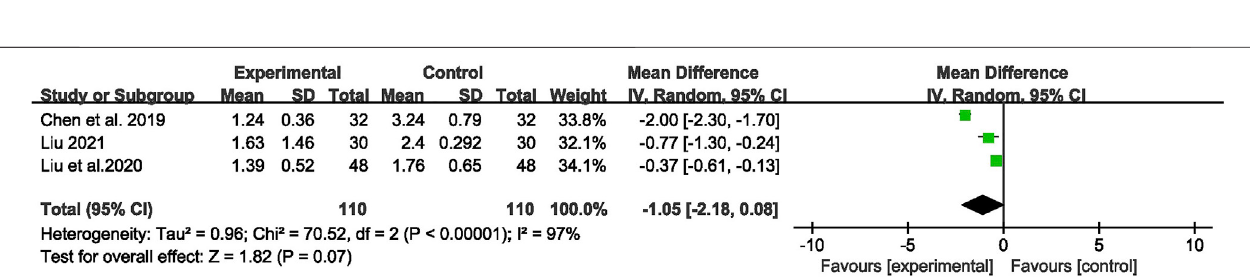
Frontiers in Pharmacology |